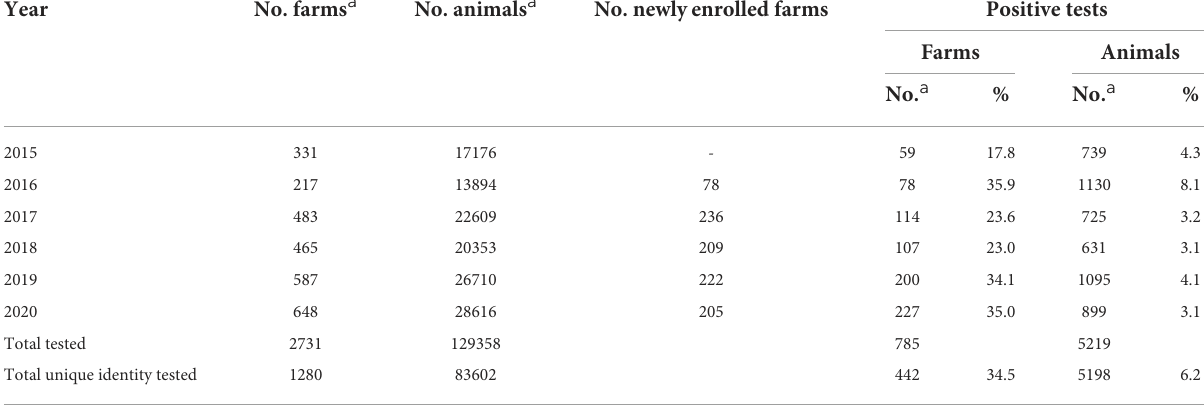
TABLE 2 Number of unique identity farms and animals tested each year for bovine tuberculosis by the Fiji BTEC program from 2015 to